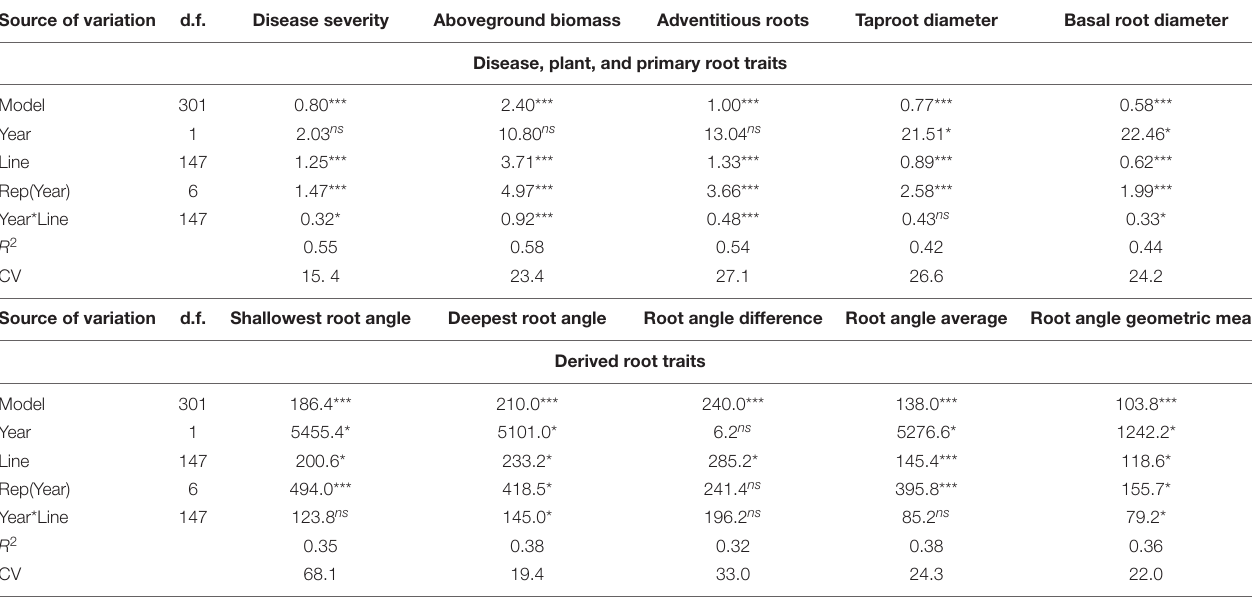
TABLE 3 | Degrees of freedom, mean squares, and significance level for model, year, bean line, replicate within year, and year by line interaction from an analysis of variance for traits associated with Fusarium solani disease reaction and plant and root parameters evaluated in trials at the Oregon State University Vegetable Research farm near Corvallis, of the BeanCAP Snap Bean Diversity Panel in 2014 and 2015. Source of variation